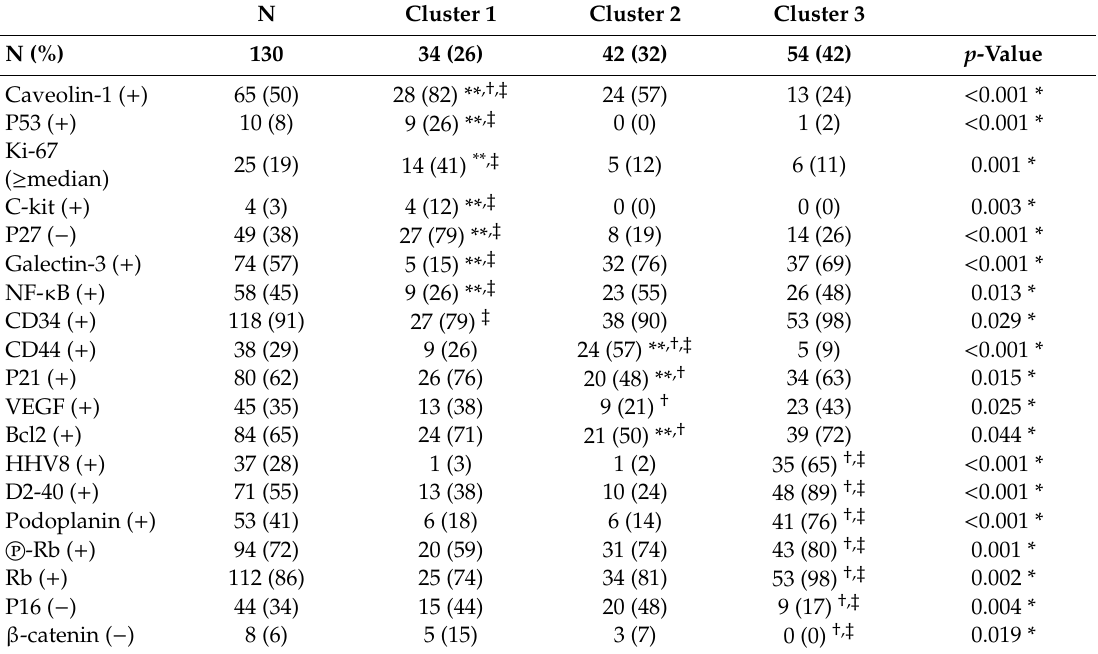
Table 2. Di ff erentially expressed 19 markers among